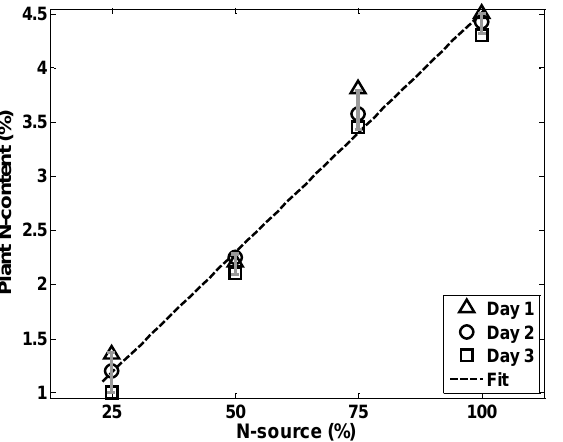
Figure 3. N-content averages (n = 5) related to the percentaje of nitrogen supplied by using standard Steiner solution per treatment per day. The dashed line belongs to the linear fitting function (R 2 =